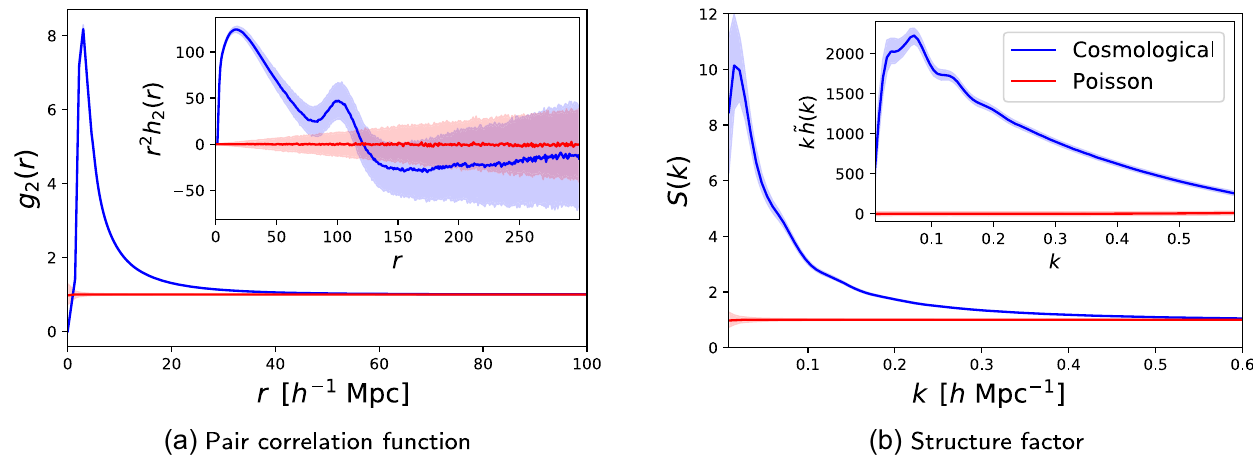
FIG. 3. Measurements of the pair correlation function (a) and structure factor (b) from 1000 QUIJOTE cosmological simulations (blue) alongside 1000 Poisson realizations (red). Both sets of simulations have the same number density ( ≈ 1 × 10 − 4 h 3 Mpc − 3 ) and a volume of 1 h − 3 Gpc 3 , with a mean pairwise particle separation of ≈ 8 h − 1 Mpc. The shaded regions show the statistical variance between realizations (which grows large on large scales), and we note that the two statistics are related by a Fourier transform. In (a), the inset shows the pair correlation function in the typical cosmologists ’ normalization, plotting r 2 h 2 ð r Þ ≡ r 2 ½ g 2 ð r Þ − 1 (cid:2) ; this clearly brings out ≈ 0 . 96 : this indicates the presence of the structure imprinted by early Universe physics. At large r , we find h 2 ð r Þ ∼ r − ð 3 þ n s Þ , where n s ˜ h ð k Þ , equal to the cosmologists ’ kP ð k Þ (with a slope of k n s on large quasi-long-range correlations. Similarly, the inset of (b) shows k scales). The oscillatory features at k ∼ 0 . 1 h Mpc − 1 arise from acoustic waves in the early